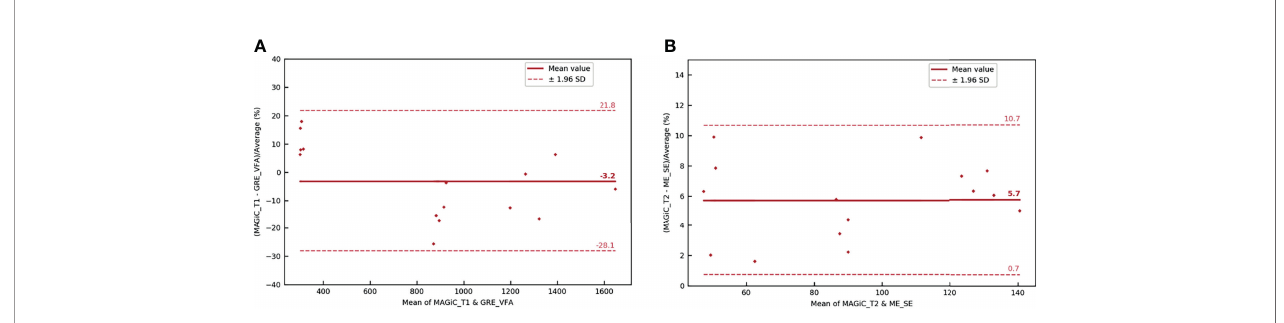
FIGURE 9 | Bland – Altman graph representing the relative difference (in percent) between the T 1 (A) and T 2 (B) maps with the MAGIC ® method and conventional sequences for the fi ve patients scanned on the prostate with the BODY coil. The red solid line marks the mean of the difference; the red dotted lines mark the mean ± 1.96 standard deviation of the difference.